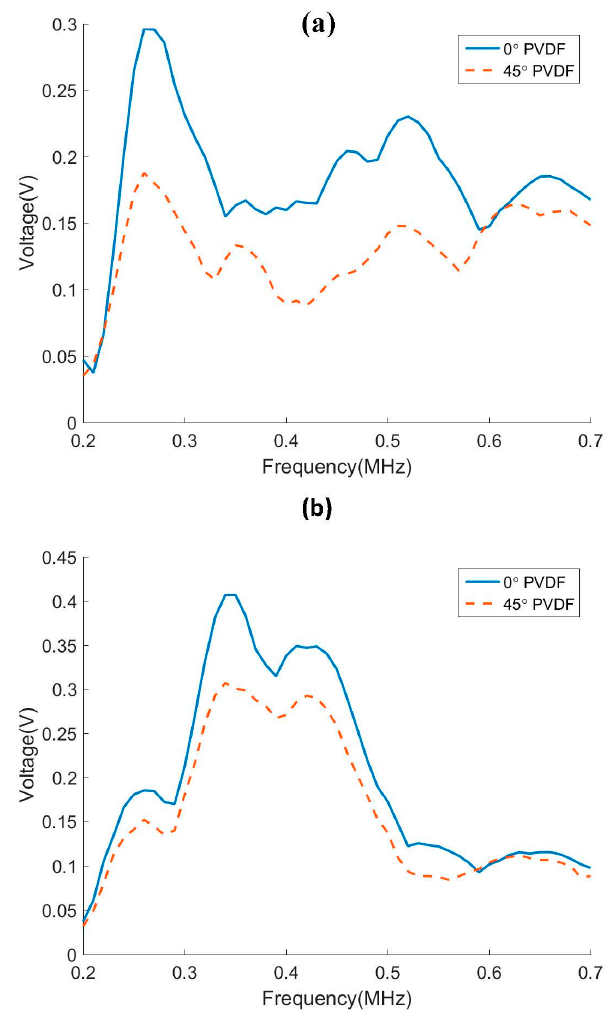
Figure 9. The sensitivity of 0° and 45° oriented PVDF sensors to the incident ( a ) A0 mode and ( b ) S0 mode.